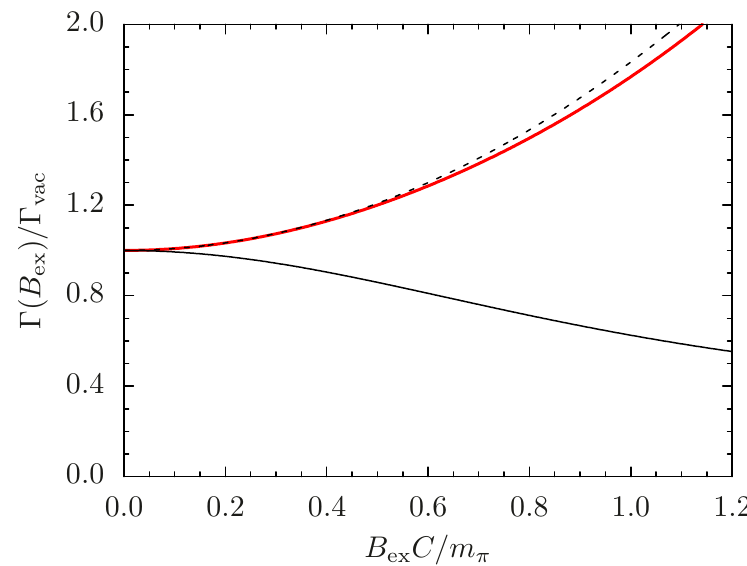
Figure 3 . Thick red line: dependence of the pion decay rate on the scaled magnetic (cid:12)eld, given by eq. (5.16). The decay rate is normalized to unity in zero magnetic (cid:12)eld; the absolute value of the decay rate in the vacuum is determined by eq. (5.15). Dashed black line: polynomial approximation for the decay rate given by the (cid:12)rst two terms in eq. (5.17). Solid black line: the decay rate without the 1 = cos 3 (cid:11) prefactor, that is, just the anisotropy factor in eq. (5.16). While all the numerical values only depend on the dimensionless ratio B ex C=m (cid:25) , the range on the horizontal axis was chosen so that, for physical values of m (cid:25) and f (cid:25) , its upper limit corresponds to B ex (cid:25) 10 20